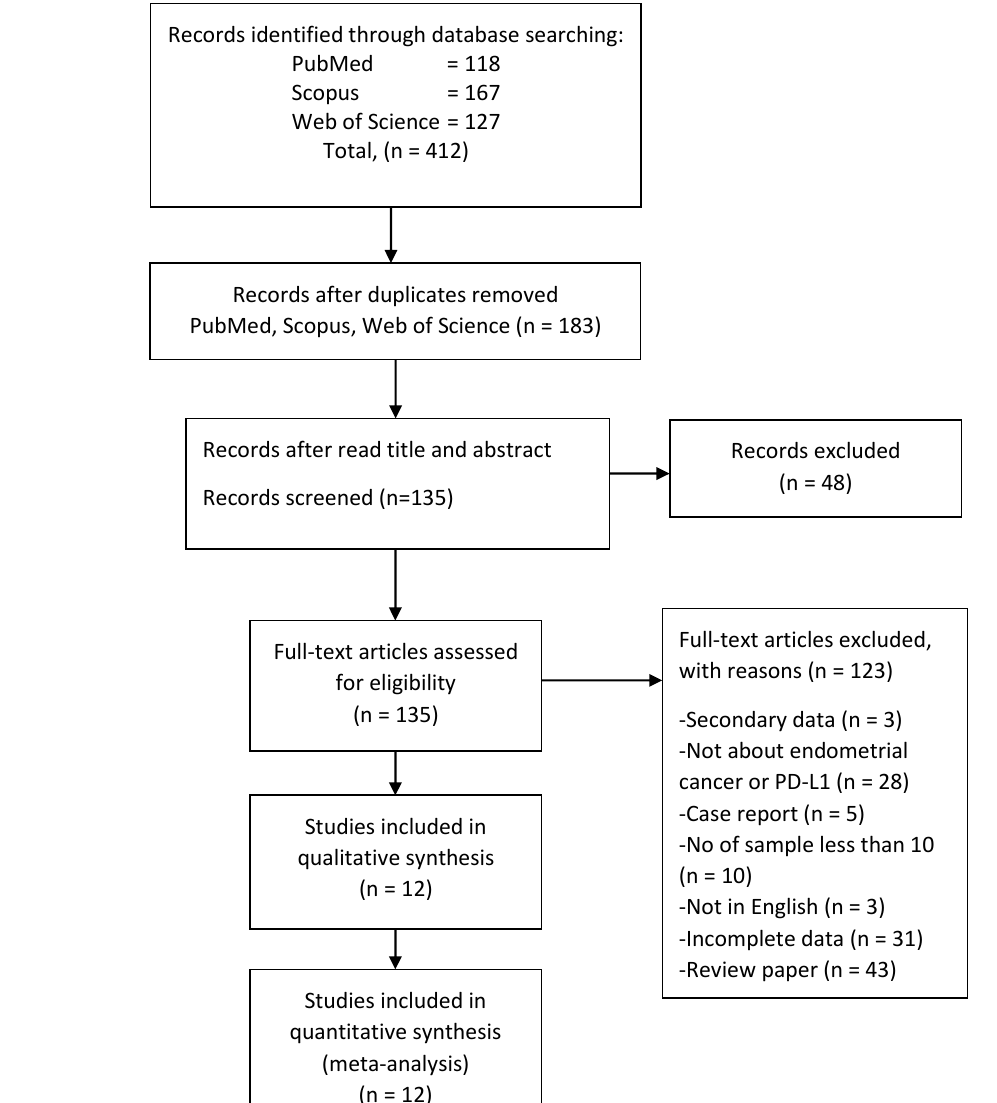
Figure 1. The PRISMA flow diagram of study selection and screening. Table 1. The risk of bias (NOS cohort).